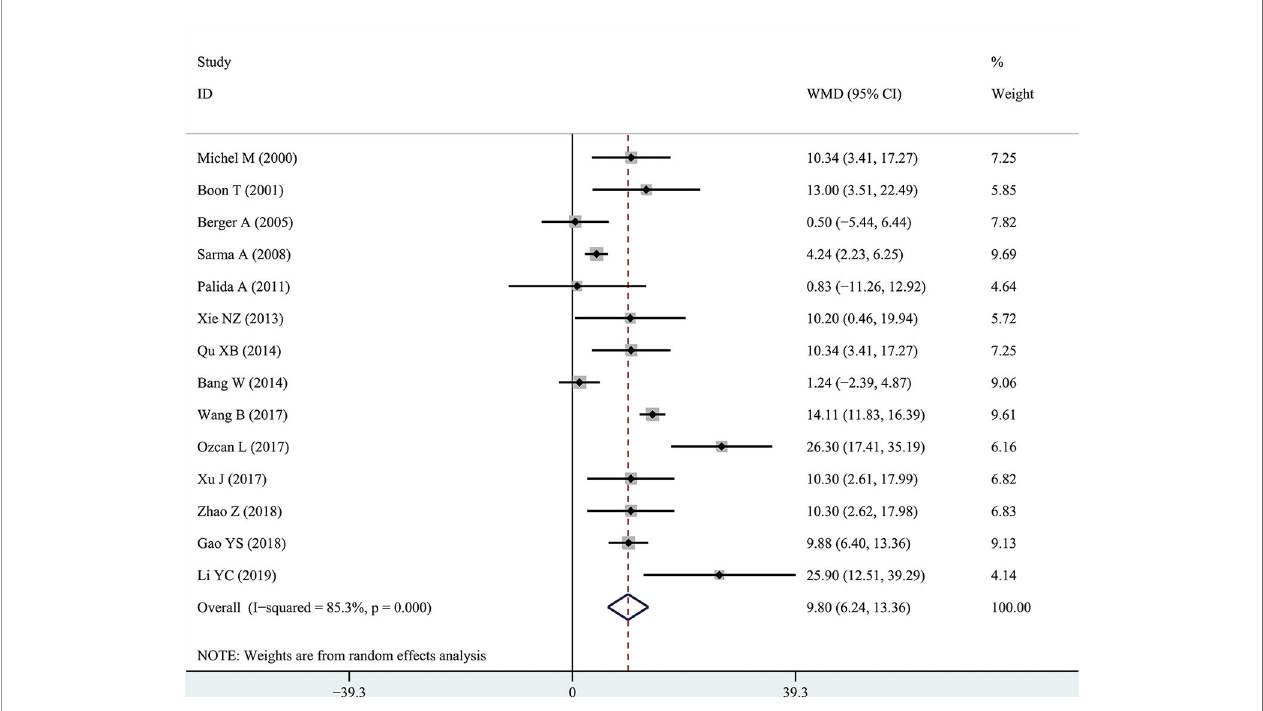
FIGURE 3 | Forest plots of prostate volume comparing diabetes group to without diabetes group in benign prostatic hyperplasia patients. The diamond represents the pooled Weighted Mean Difference (WMD) and 95% con fi dence intervals (CI).